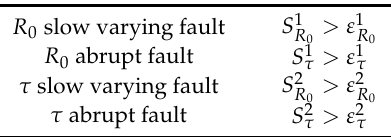
Figure 3. Parameter ‐ biased fault diagnosis process of battery cell. Table 1. Fault map. Table 1. Fault map.